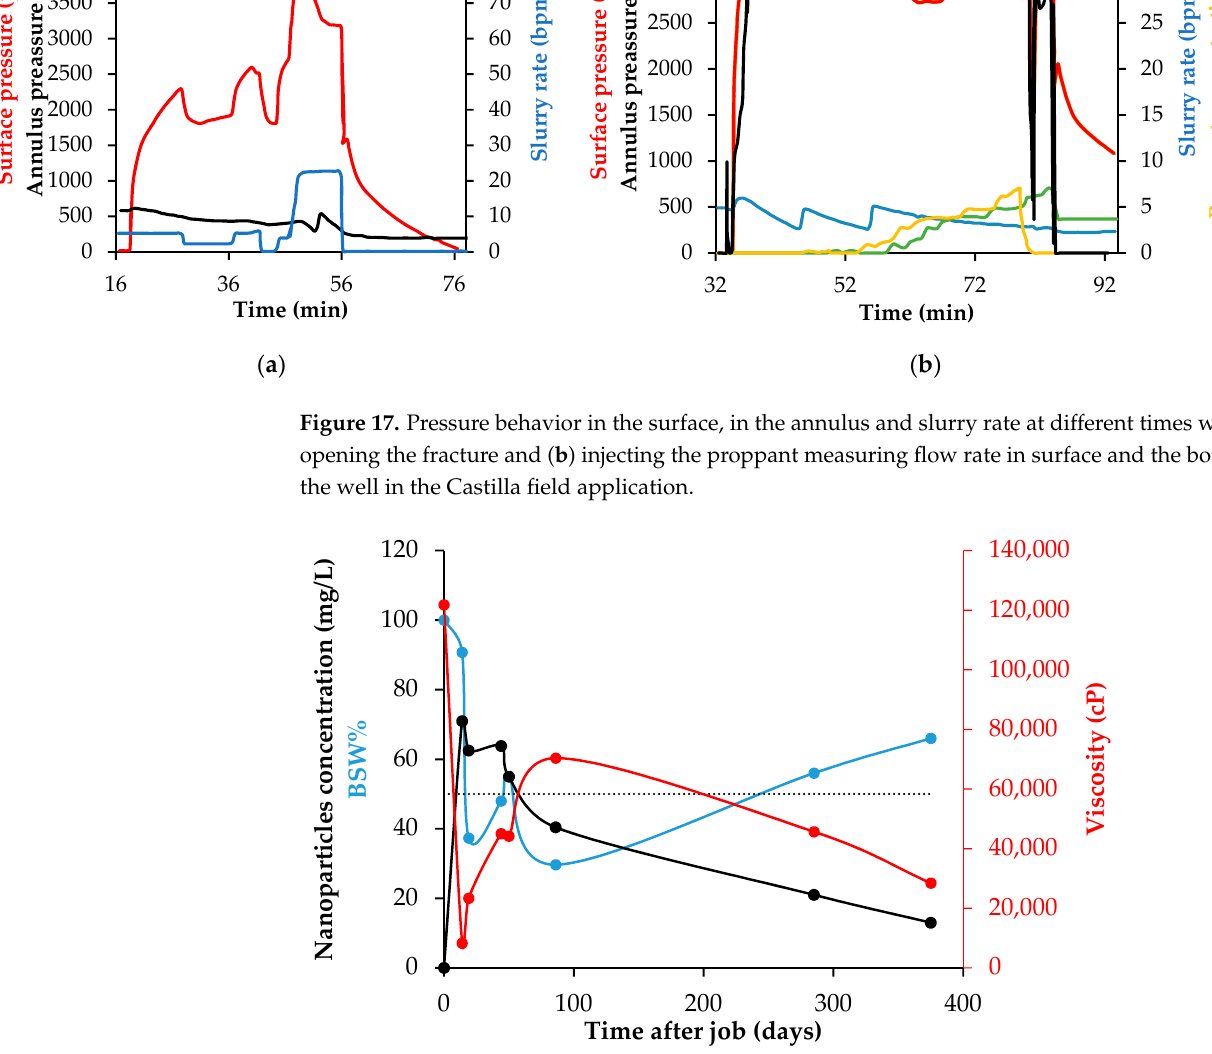
Figure 18. Behavior over time for the viscosity, BSW% residual nanoparticle concentration for the produced oil in the well when was carried out the fracking operation with the optimized NanoFF in the Castilla oil field.